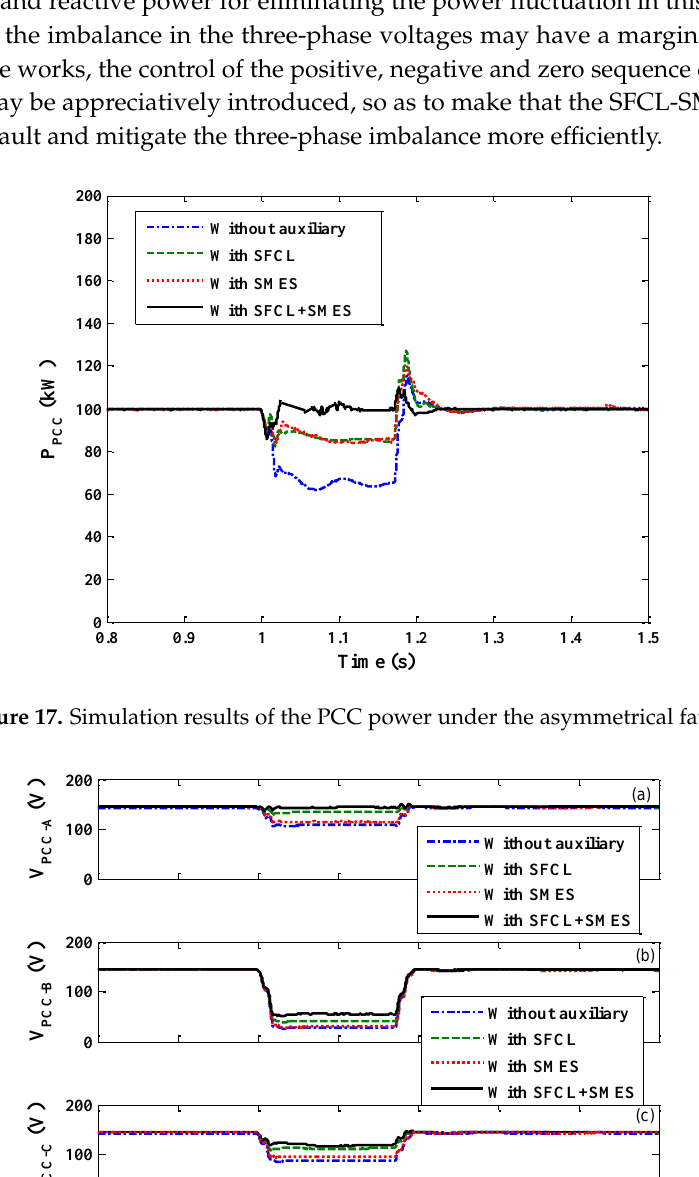
Figure 19. Simulation results of the DC-link voltage under the asymmetrical fault.